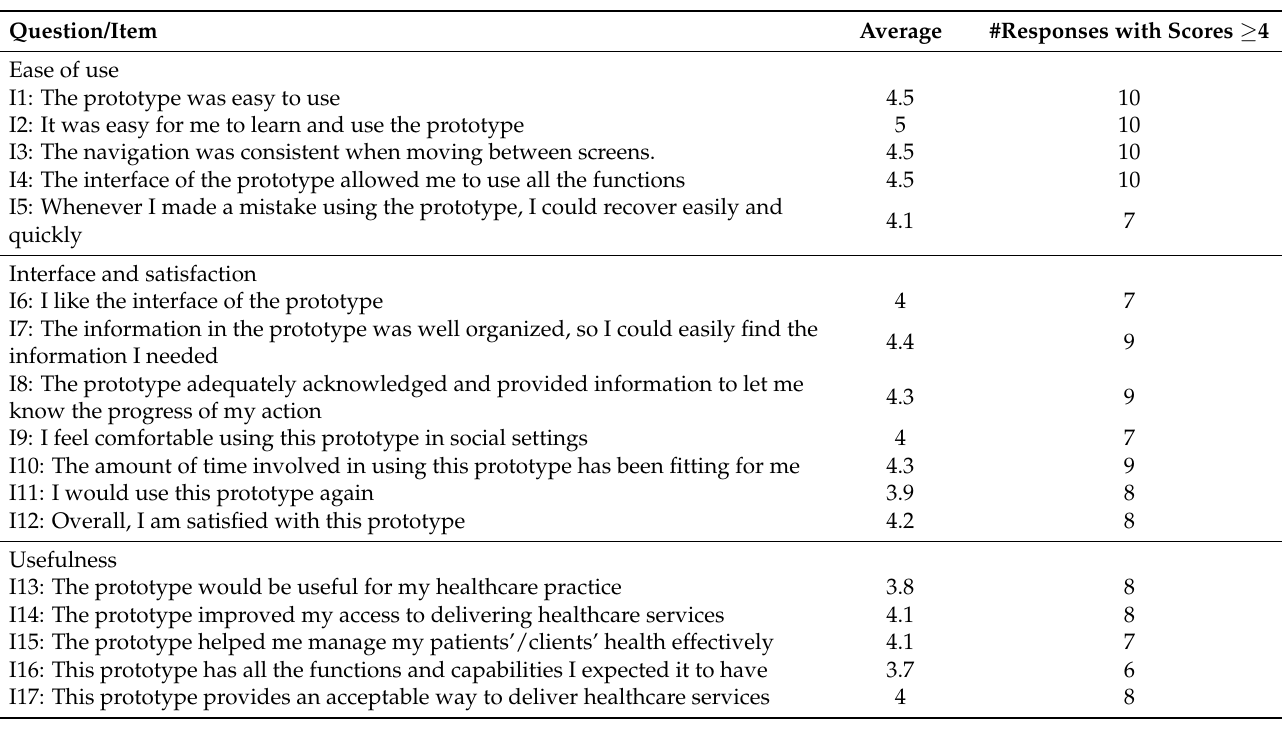
Table 2. Results of the Usability Questionnaire.